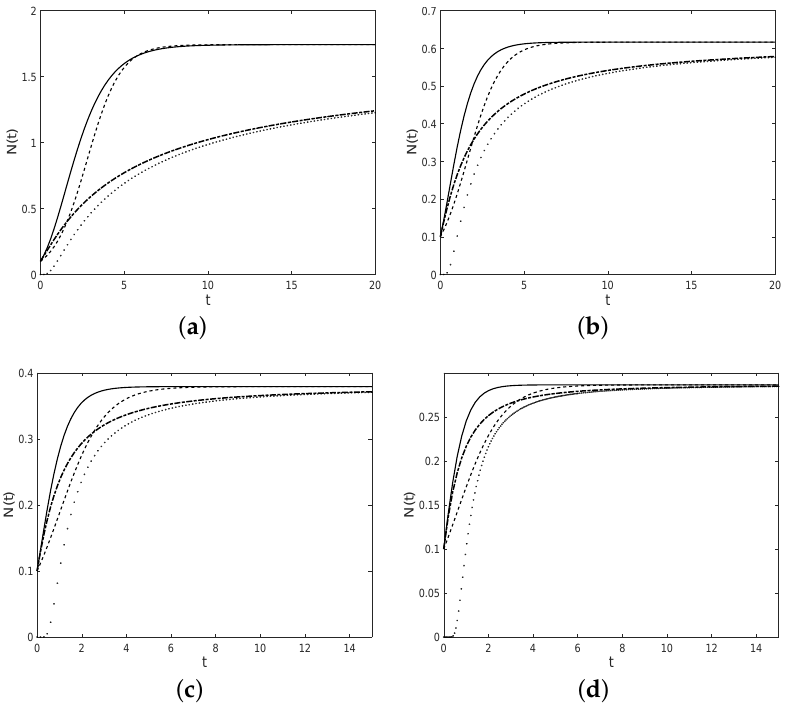
Figure 1. Gompertz-like curve N G (full), Korf curve N K (dotted), modified Korf curve N MK (dot-dashed), and the logistic curve N (dashed), for y = 0.1, A = 0.1, α = 2, r = 1, ( a ) β = 0.7 and C = 1.7412, ( b ) β = 1.1 and C = 0.6161, ( c ) β = 1.5 and C = 0.3794, ( d ) β = 1.9 and C = 0.2865.